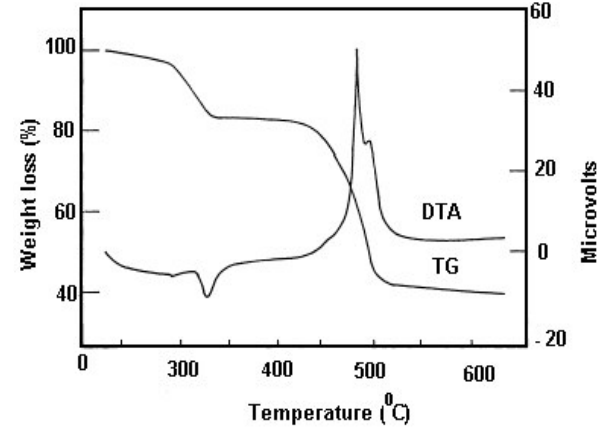
Figure 2. TG/TDA result on LiNd 0.3 Mn 1.7 O 4